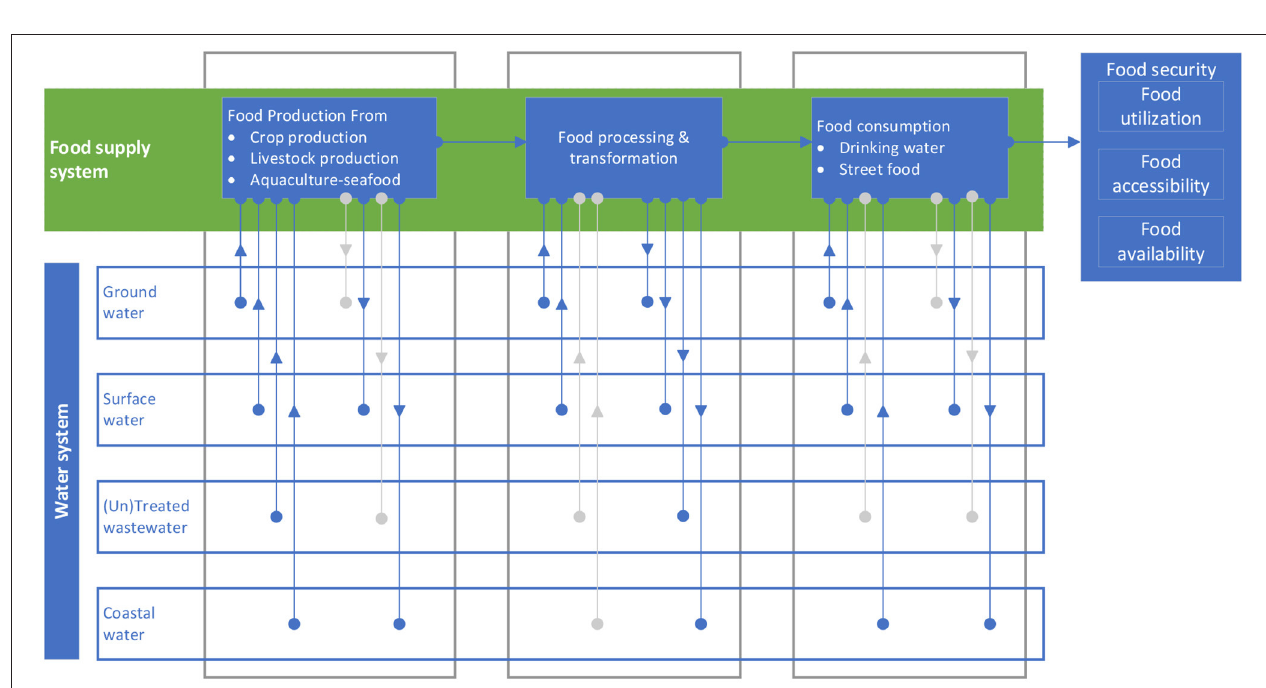
FIGURE 2 | Framework of water systems and food systems relating to water quality (storage and distribution, and food distribution not included). Derived from de Lange et al. (2021).